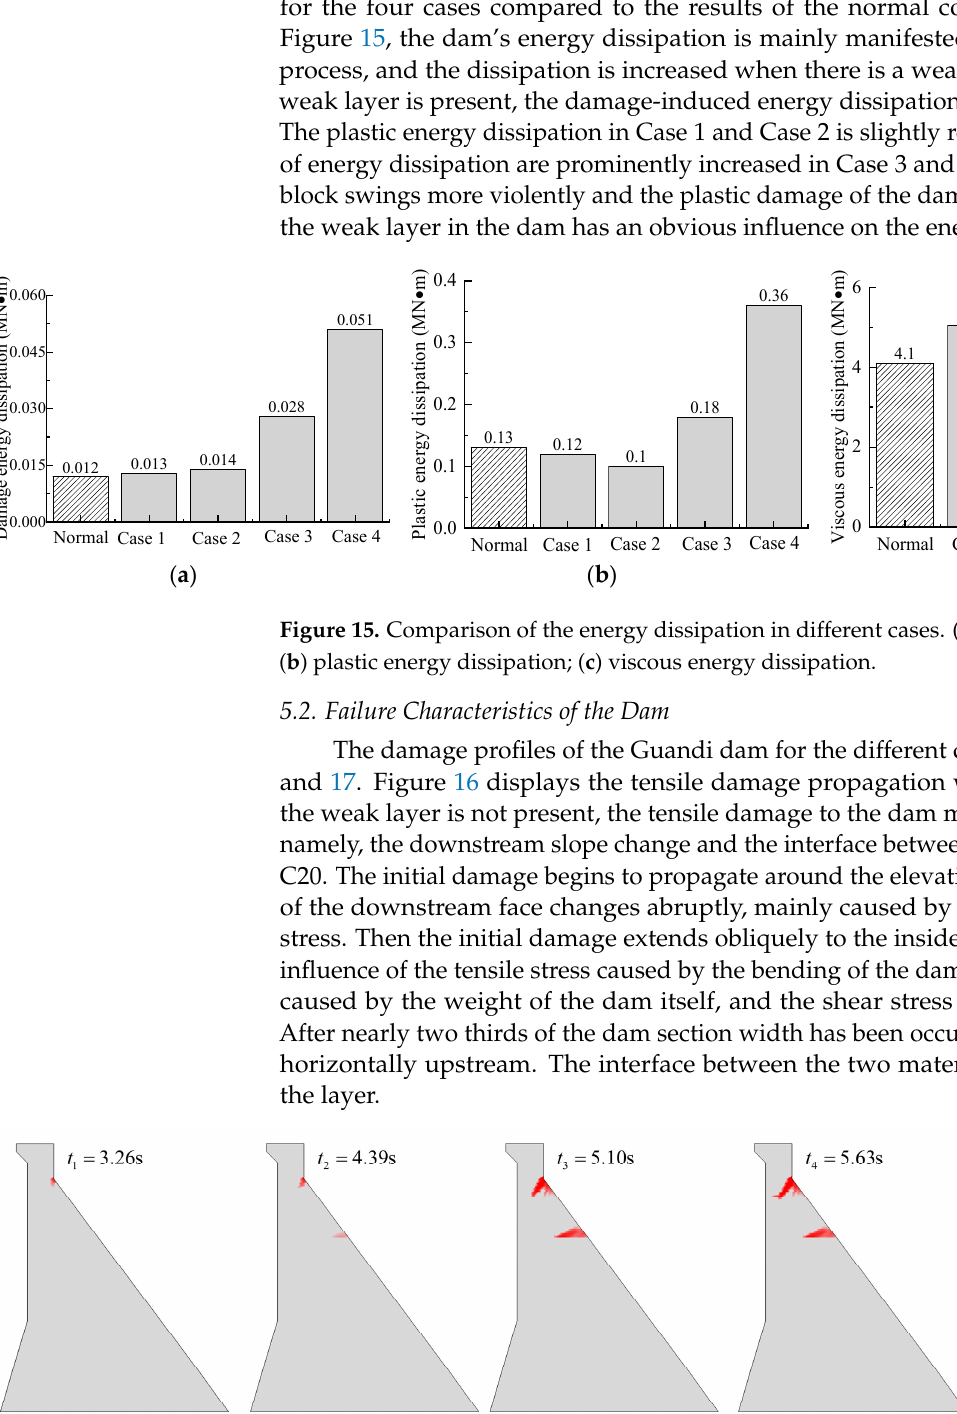
Figure 16. Damage evolution of the normal concrete dam during the Koyna earthquake.